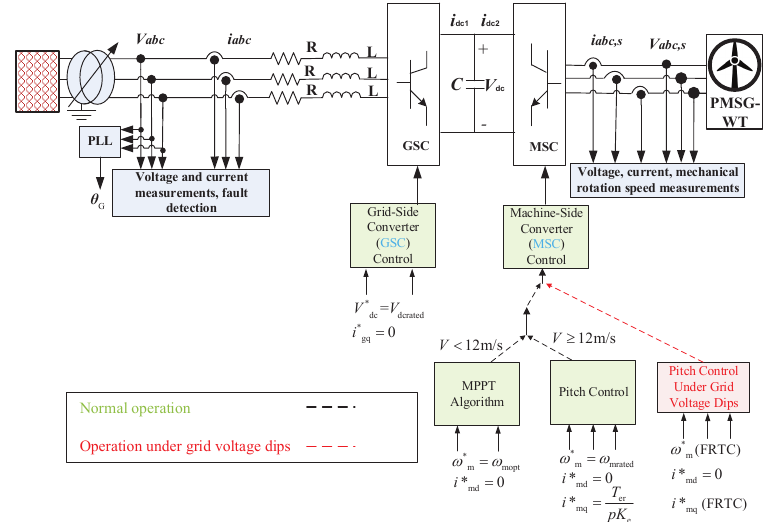
Figure 2. Control block diagram under normal operation and grid voltage